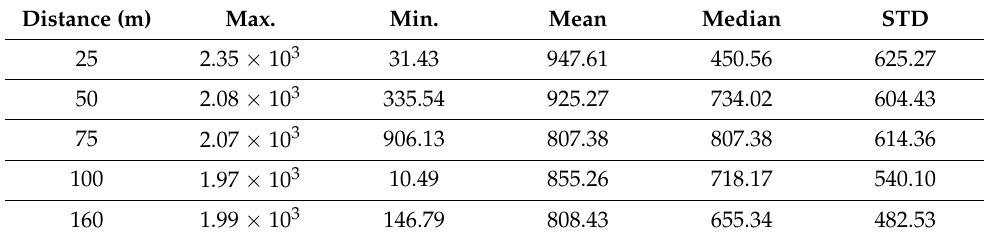
Table 2. Throughput quality status attained from 25 to 160 m UET communication distance. Distance (m) Max.